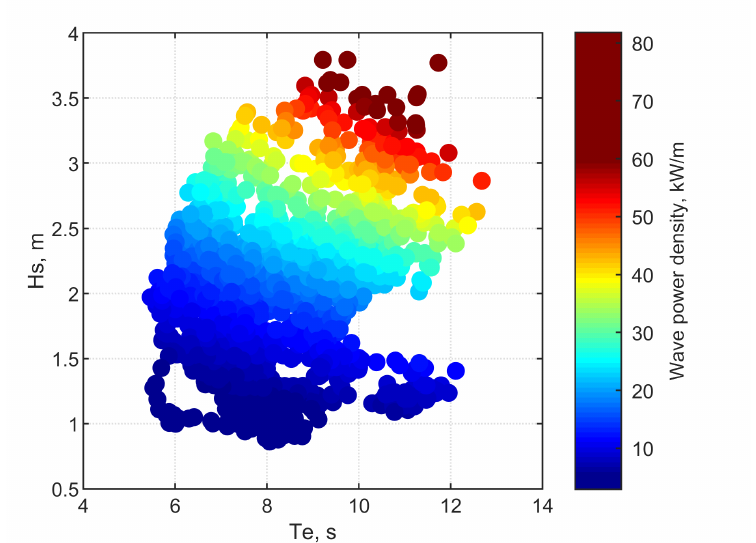
Figure 10. Wave power density, calculated for all sea states for March 2018 at Wave Hub,